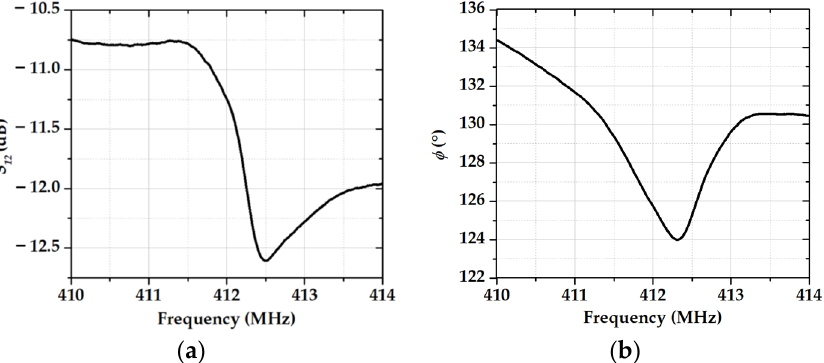
Figure 5. The frequency dependencies of ( a ) the S 12 parameter and ( b ) the phase for device #1, coated with LB film consisting of 17 monolayers of AA.